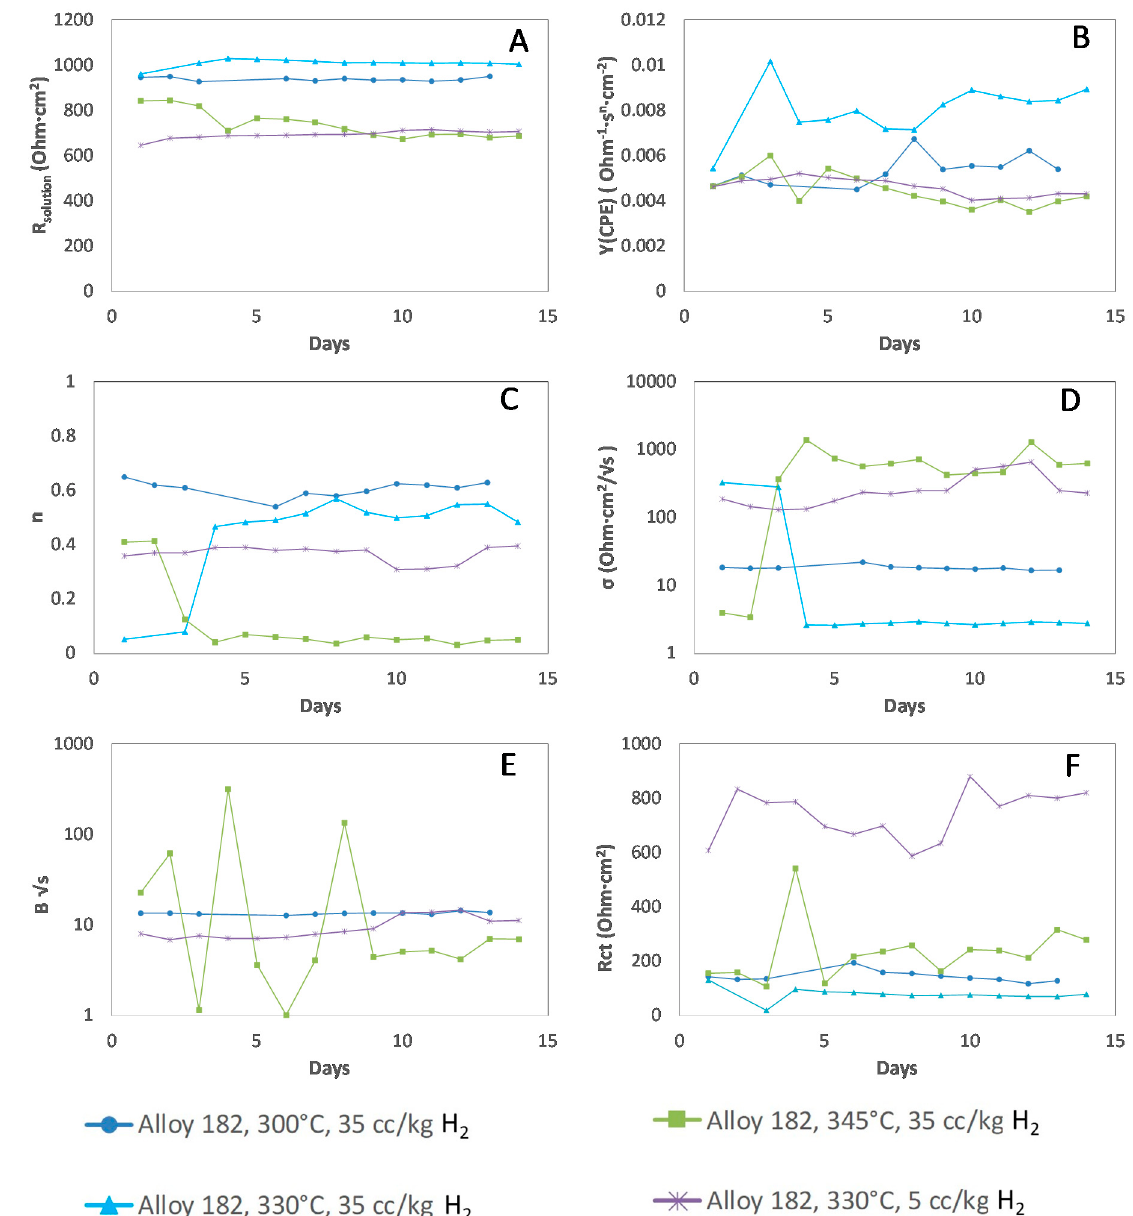
Figure 11. Fit results as a function of time: ( A ) solution resistance Rsolution, ( B ) CPE constant Y(CPE), ( C ) CPE exponent n , ( D ) Warburg coefficient σ , ( E ) diffusion parameter B, and ( F ) charge transfer resistance Rct.